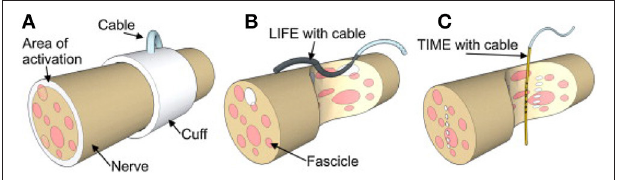
FIGURE 1 | A schematic drawing of (A) Cuff electrode, (B) LIFE electrode, (C) TIME electrode. Figure from Boretius et al.